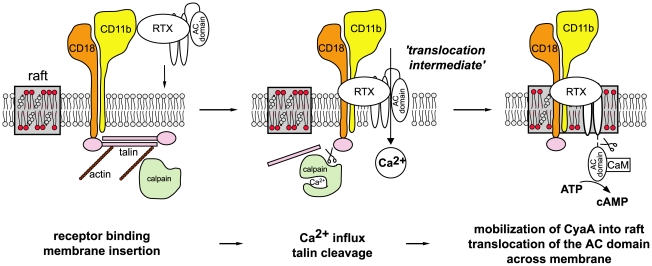
Model of CyaA translocation across target cell membrane.In the first step, CyaA binds the CD11b/CD18 integrin receptor dispersed in the bulk of the membrane phase outside of lipid rafts, having the cytoplasmic tail of the CD18 subunit tethered to actin cytoskeleton via the linker protein talin. Upon receptor engagement, a ‘translocation intermediate’ of CyaA inserts into the lipid bilayer of cell membrane with the AC domain partially penetrating into cell membrane together with the pore-forming segments of the toxin and participating in formation of a transiently opened Ca2+-conducting path across cell membrane. Influx of external calcium ions into cells induces activation of the Ca2+-dependent protease calpain, yielding talin cleavage and liberation of the CyaA-CD11b/CD18 complex from binding to actin cytoskeleton. Consequently, CyaA is recruited with CD11b/CD18 into cholesterol-enriched lipid rafts, where the liquid-ordered packing of lipids and the specific presence of cholesterol enable completion of AC domain translocation across cytoplasmic membrane. Upon exposure at the cytosolic side of cell membrane, the AC domain is cleaved-off from the RTX cytolysin moiety of CyaA by a protease residing inside the cell. Binding of cytosolic calmodulin (CaM) then activates the AC enzyme and unregulated conversion of ATP to cAMP is catalyzed.